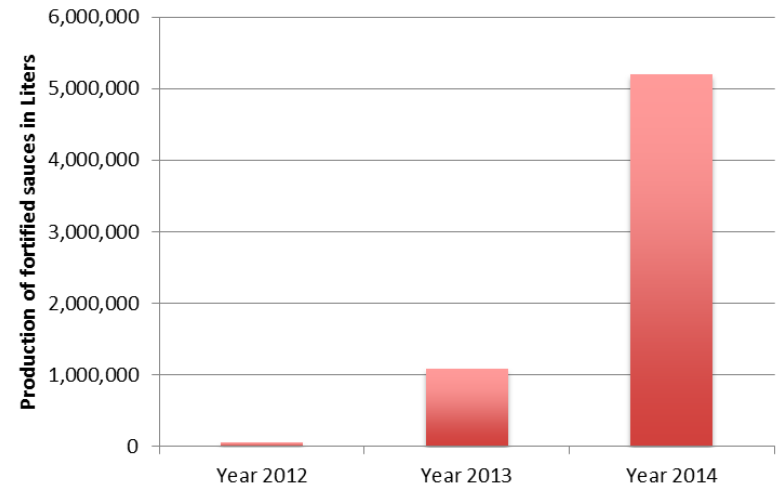
Figure 1. Production of iron fortified fish and soy sauce between 2012 and 2014 (in liters).